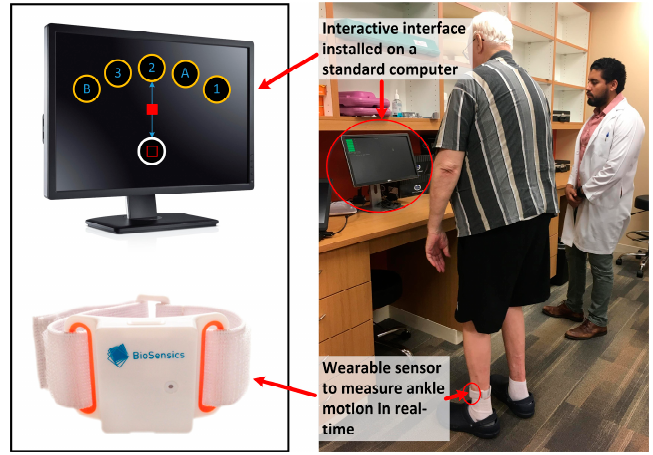
Figure 1. An illustration of the instrumented trail-making task (iTMT) platform with both numbers (1, 2, and 3) and letters (A and B) randomized in the target circles. One inertial sensor—including a triaxial accelerometer, a triaxial gyroscope, and a triaxial magnetometer—was attached to the subject’s lower shin using a comfortable elastic band. The sensor allows measurement of three-dimensional motion of the ankle joint in real time. The instantaneous measured joint angle with a sample frequency of 100-Hz was wirelessly transferred to a computer, using low-power Bluetooth, to create an interactive interface for the purpose of the interactive iTMT test. For safety purposes, a research coordinator was in the room supervising the iTMT test at all times. After starting the iTMT test, the research coordinator did not provide any guidance. The interactive interface provided the necessary guidance and instruction to complete the test.